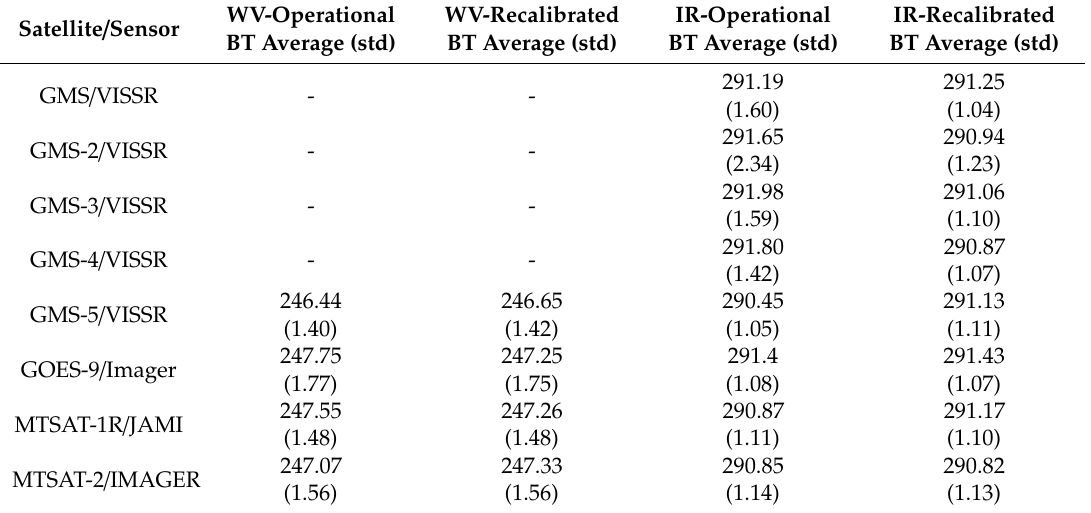
Table6. Statisticsoftheoperationalandrecalibratedbaselinesensornormalizedbrightnesstemperatures (K) for the WV and IR channel of the JMA satellites. The statistics are given as average and standard deviation (given in brackets).